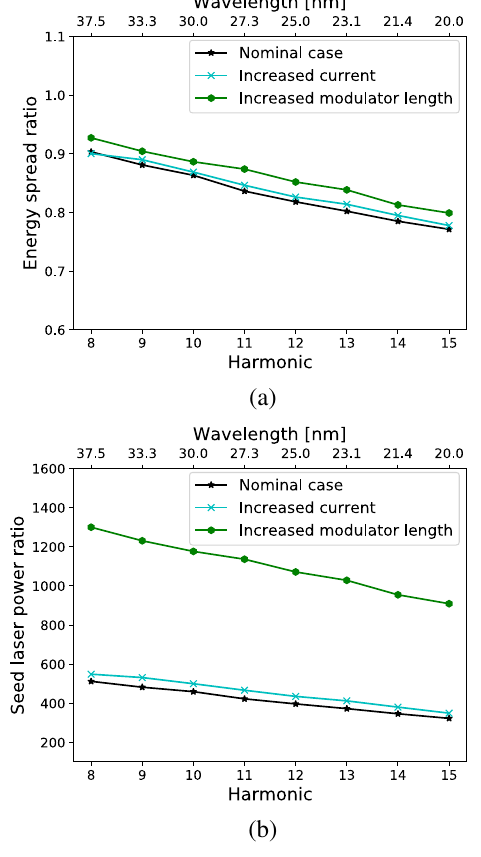
FIG. 4. (a) Required energy spread ratio between the two = σ 0 schemes ( σ 0 ) to obtain 8% bunching at differ- E ; HGHG E ; OK-HGHG ent harmonics. In addition to the standard parameters (Table I) also higher peak current and longer undulators are studied. The energy spread ( σ 0 ) is measured upstream from the amplifier. E (b) Ratio between the minimum seed laser power required for =P both schemes ( P ) to obtain the same seed ; HGHG seed ; OK-HGHG bunching for the cases studied in